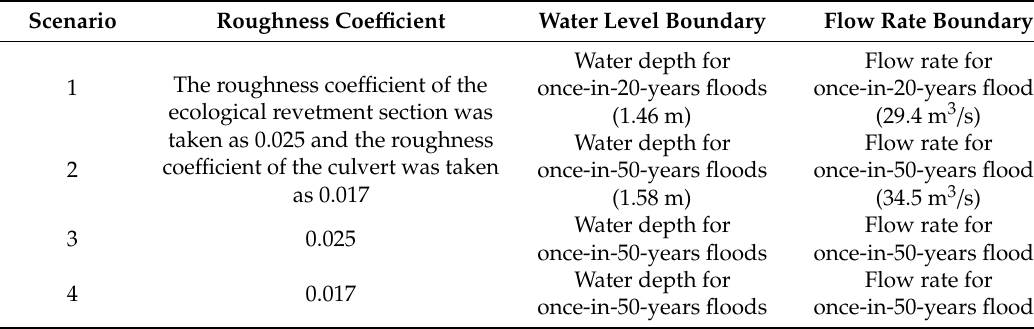
Table 3. Simulation